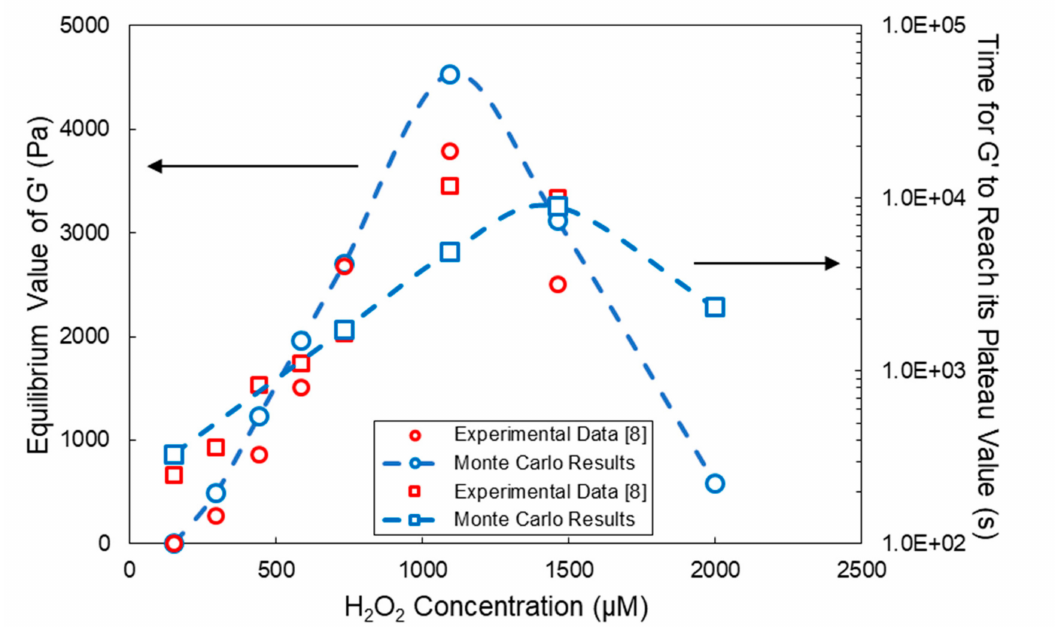
Figure 10. Effect of the H 2 O 2 concentration on the G (cid:48) equilibrium value and time required for G (cid:48) to reach its plateau value for the HA-Tyr crosslinkable solution (i.e., 1.75% w/v , MW = 90 kDa and HRP concentration = 0.062 units/mL). Blue squares with a blue dashed line and blue circles with a blue dashed line represent the MC calculated values, and red circles and squares denote the respective experimental measurements of Lee et al. [8]. All MC simulations were conducted with an initial polymer chain population of ~10 6